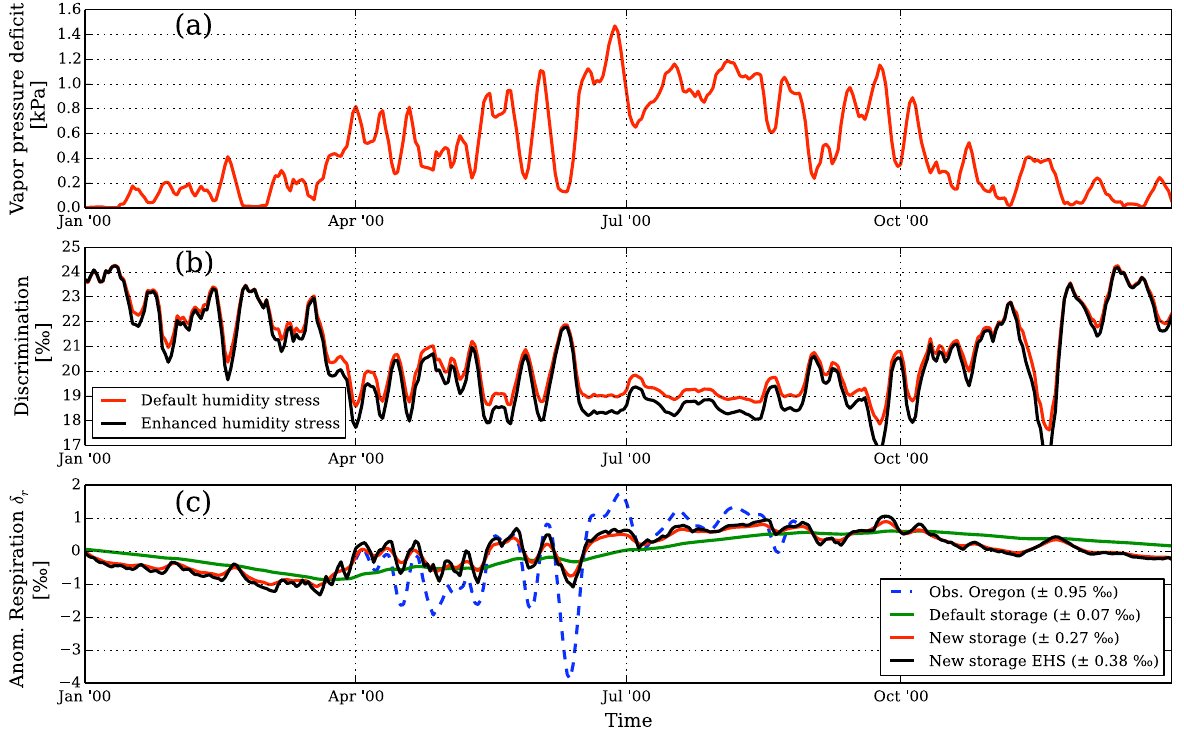
Figure 8. Daily vapor pressure deficit (a) , isotopic discrimination (b) , and anomalies relative to the mean in the isotopic signature in au- totrophic respiration (c) for the year 2000 simulated in Oregon. Panel (c) depicts the δ r in respiration from the single storage pool (green line) and the new storage pool structure (red line), and in addition, δ r predicted with the curve fits determined in Oregon (Bowling et al., 2002, blue dashed line). The 1 σ (detrended) variability between April and August is shown in the legend. The estimates due to enhanced humidity stress (EHS) are shown in (b) and (c) as a black